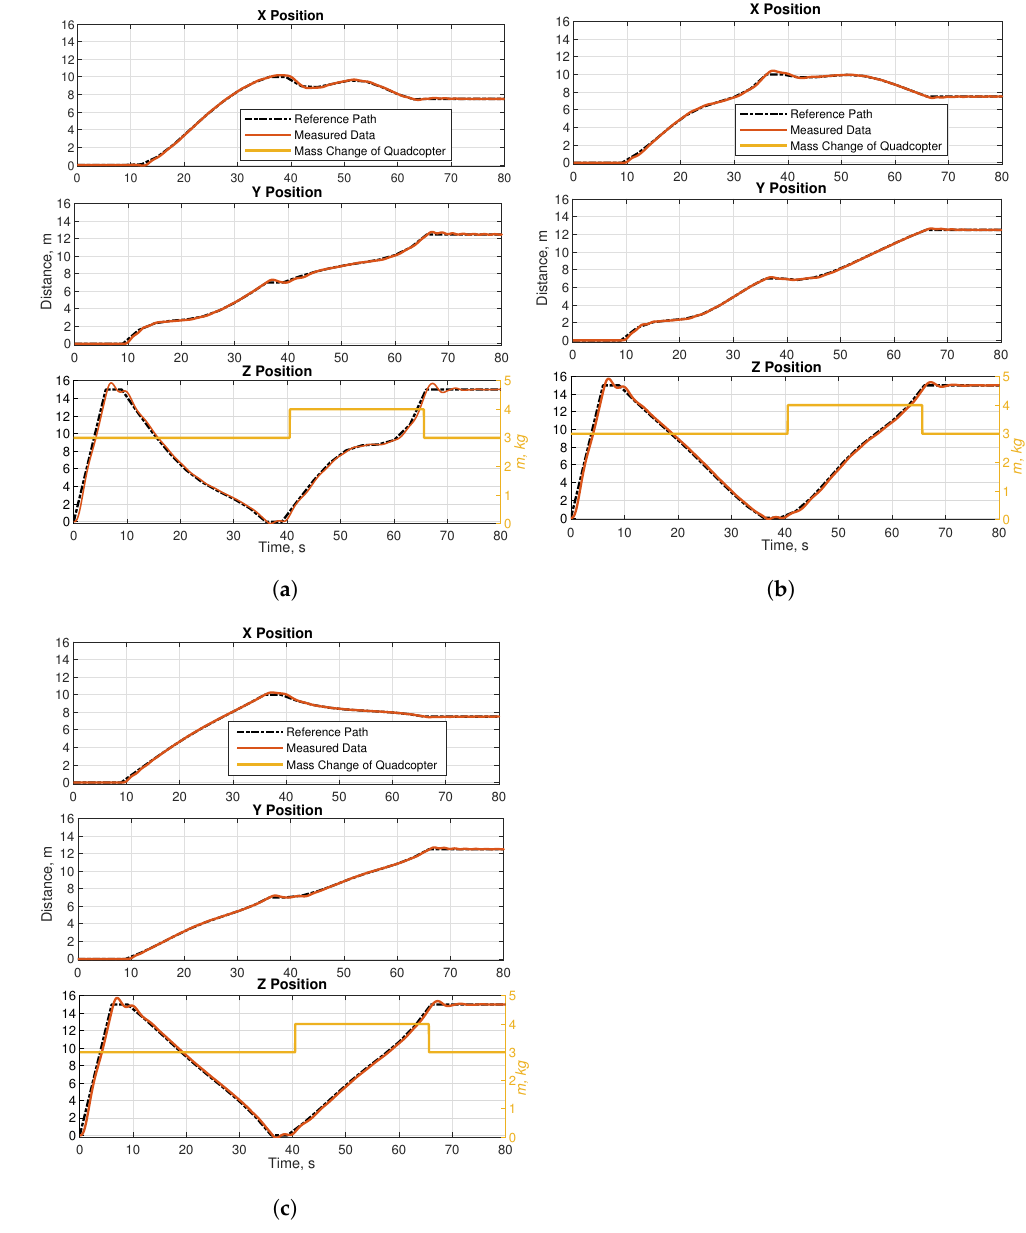
Figure 12. The path-tracking performance of the quadcopter for Map 1 ( a ) using PSO, ( b ) using GWO, and ( c ) using hybrid